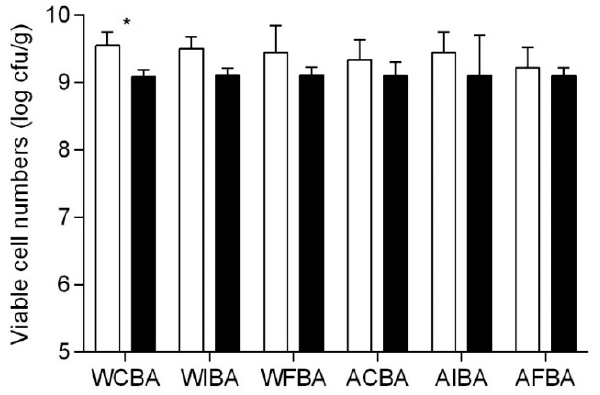
Figure 1. Bifidobacterium animalis subsp. lactis BB-12 total viable counts during air drying for each film composition (as described in Table 1). Each bar represents the mean with standard deviation of the film samples produced ( n = 3). Asterisk indicate significant difference between the drying process. *: p < 0.05; white bar = start of drying, and black bar = end of drying.